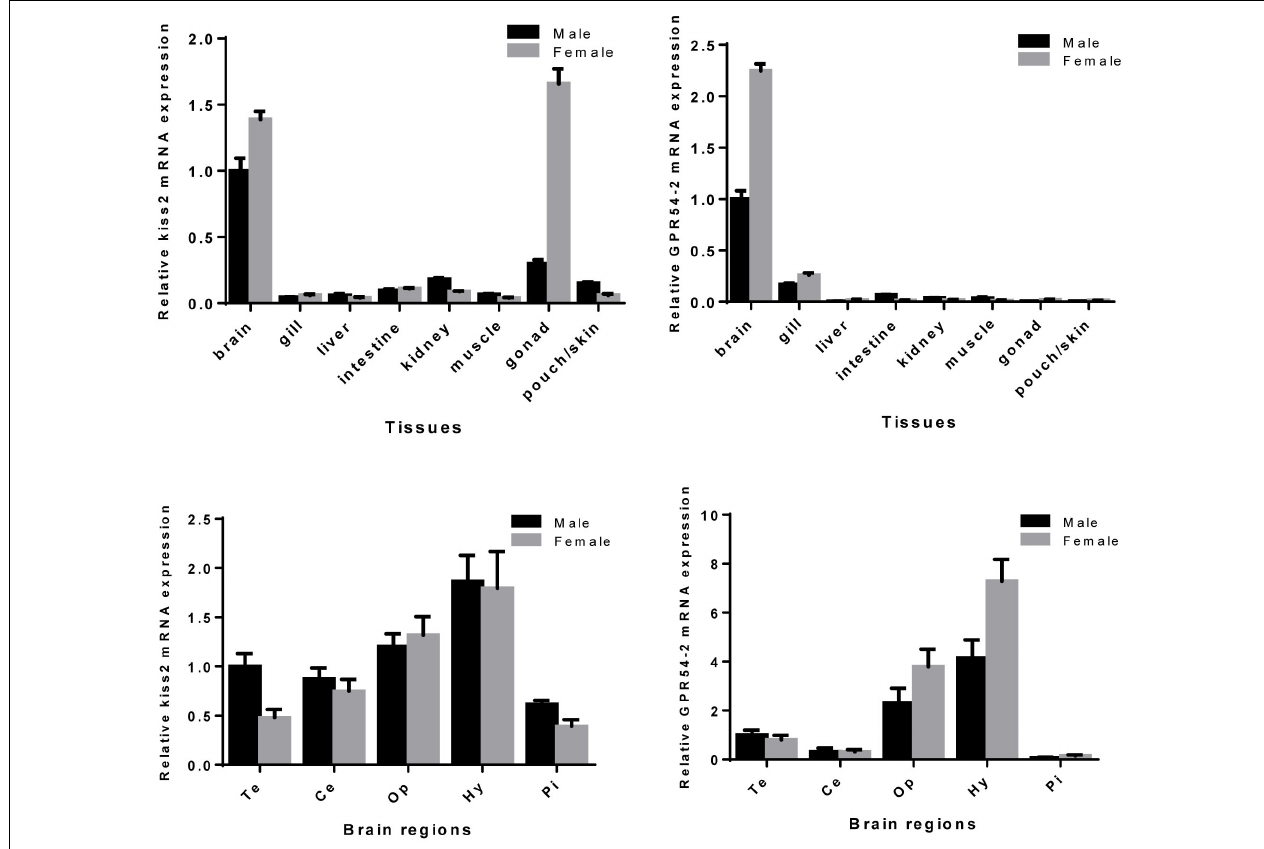
FIGURE 5 | Relative mRNA expression levels of kiss2 and GPR54-2 mRNA in various tissues and brain regions of male and female seahorses. The brain regions including: Te, telencephalon; Ce, cerebellum; Op, optic tectum-thalamus; Hy, hypothalamus; Pi, pituitary. The mRNA expression levels are identified by real-time PCR, normalized against the β -actin transcript, and presented as means ±